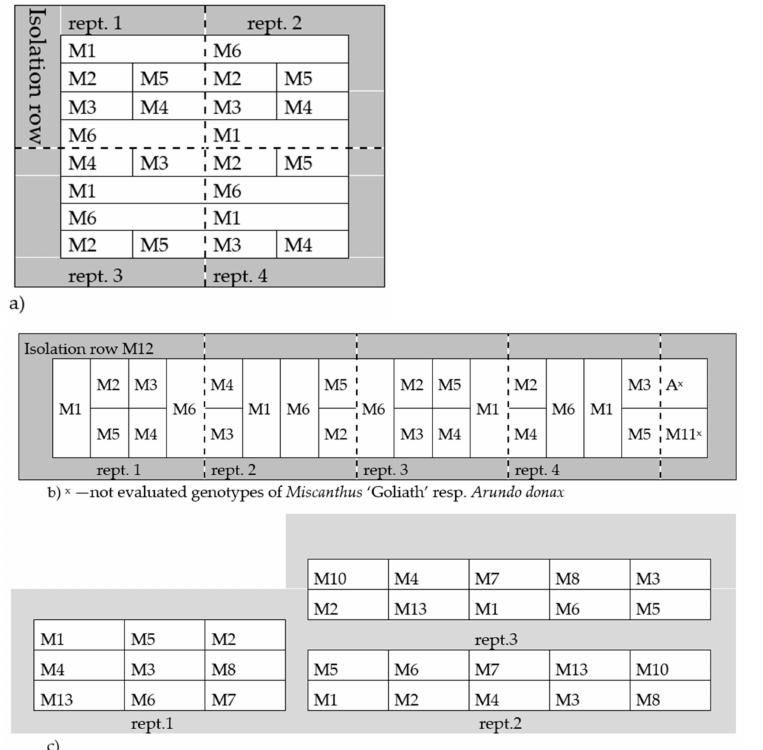
Figure 3. Design of field experiments used for data collection: ( a ) Scheme of the clonal experiment in Lukavec; ( b ) Scheme of the clonal experiment in Pr˚uhonice-Michovky; ( c ) Genotype collection Pr˚uhonice-Zelin á ˇrsk á zahrada; rept.1–4 are repetitions of field